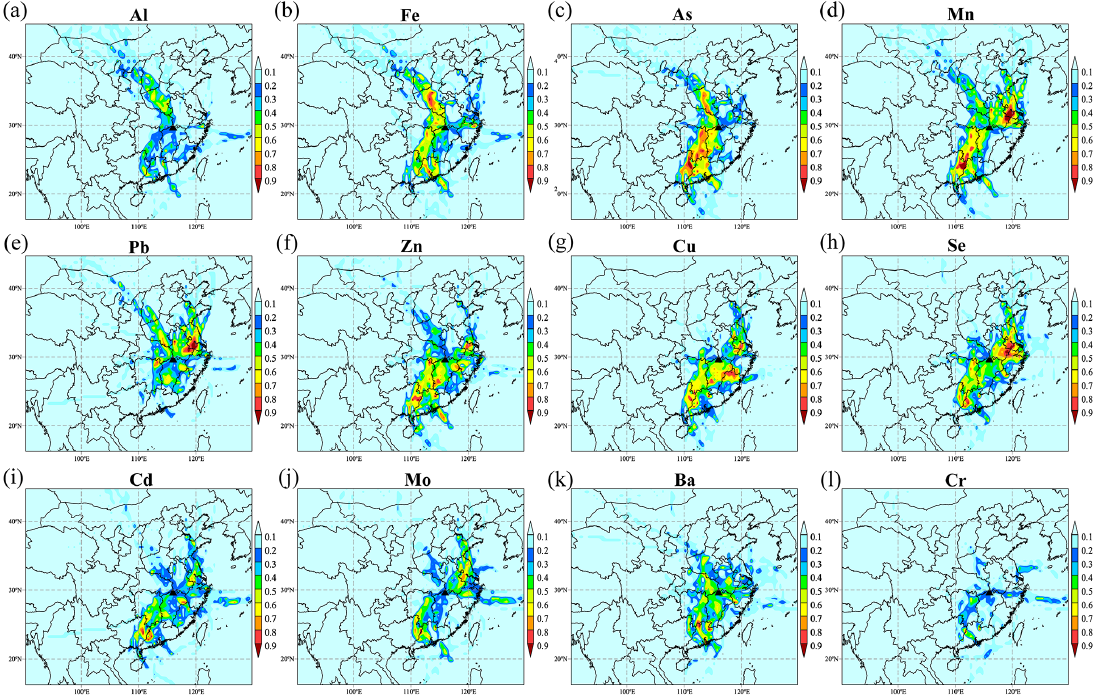
Figure 6. Likely source regions of individual elements in PM 2 . 5 at Mt. Lushan, identified using PSCF plots. Note the criteria are the 75th percentile for Al and the mean concentration for others.